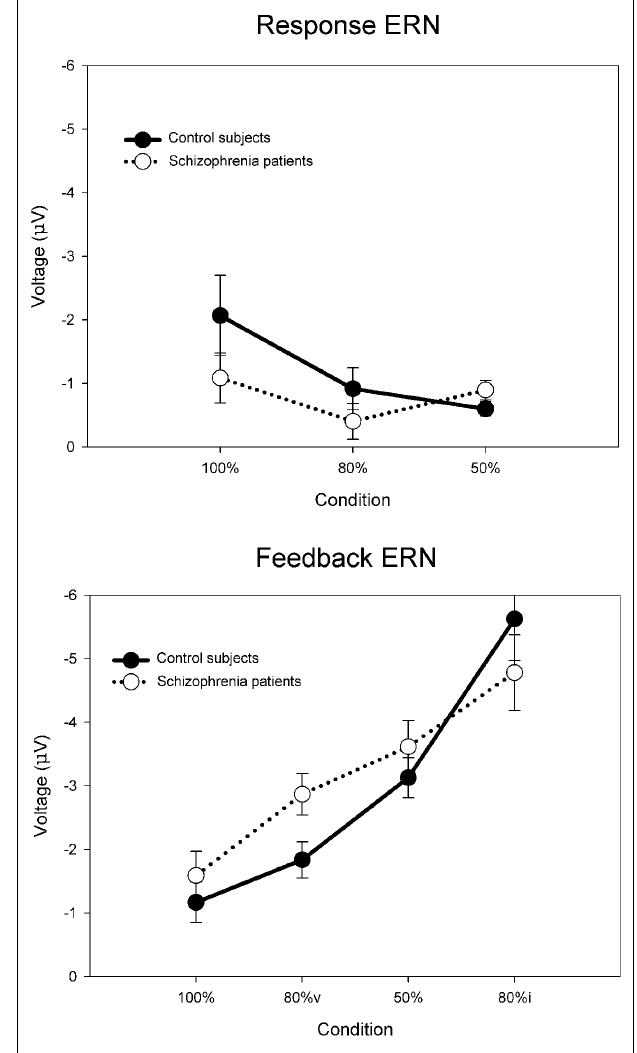
FIGURE 6 | Empirical control and schizophrenia ERN difference wave data (mean amplitude and SE) for the probabilistic learning task, for the response ERN (top) and feedback ERN (bottom). Note that “80%v” and “80%i” correspond to trials in the 80% condition with either valid or invalid feedback, respectively. Data recorded at FCz and re-analyzed from Morris et al.